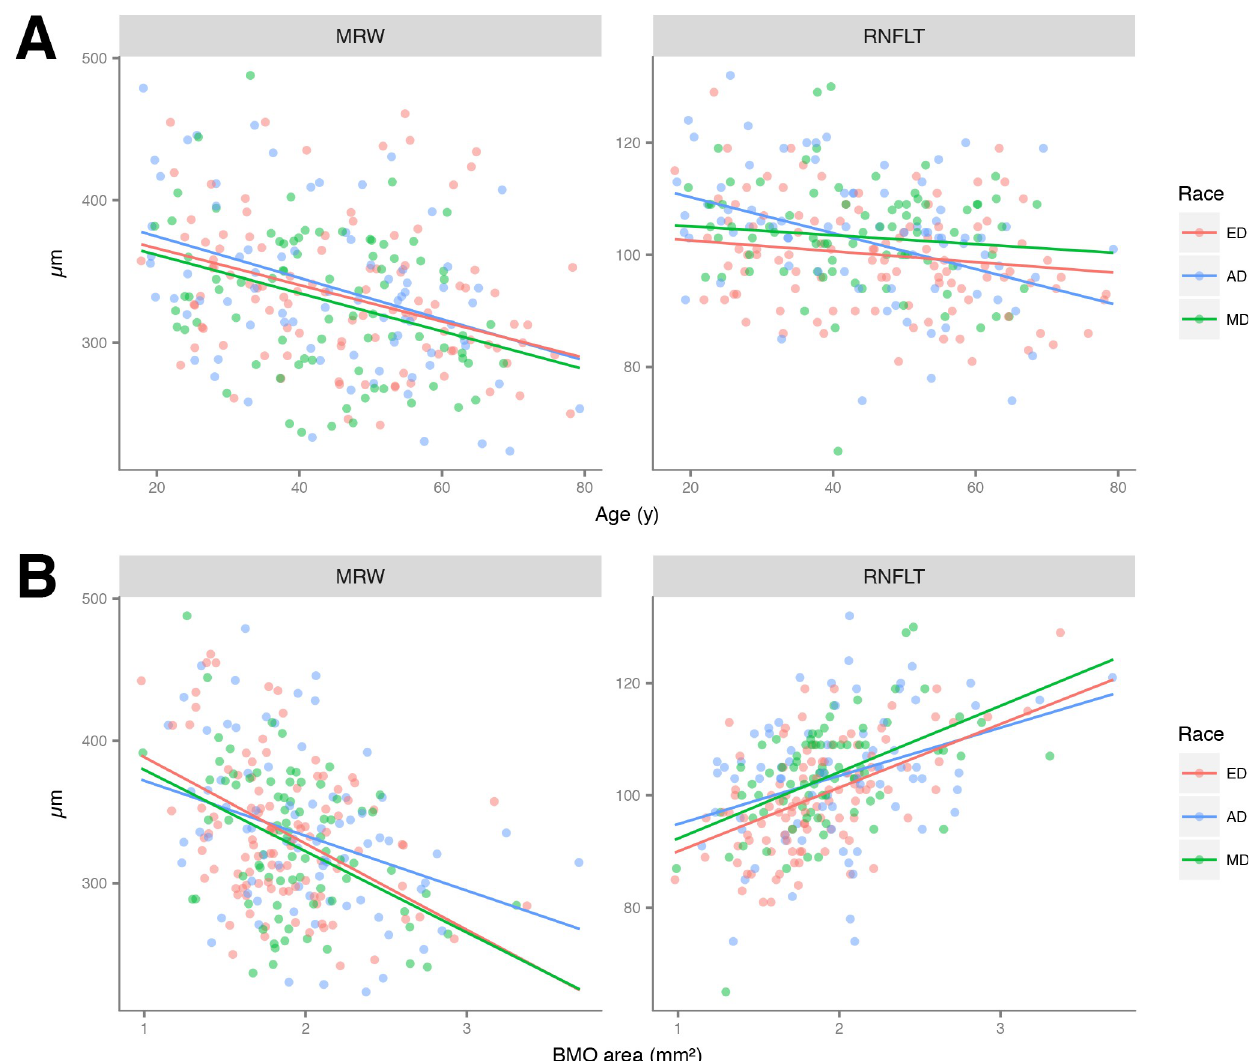
Fig 4. (A) Scatterplots showing the relationship between global minimum rim width (MRW) and age (left) and global peripapillary retinal nerve fiber layer thickness (RNFLT) and age (right), by racial group. Lines represent the coefficients of multivariable regression, adjusted for Bruch’s membrane opening area. (B) Scatterplots showing the relationship between global minimum rim width (MRW) and Bruch’s membrane opening (BMO) area (left) and global peripapillary retinal nerve fiber layer thickness (RNFLT) and BMO area (right) by racial group. Lines represent the coefficients of multivariable regression, adjusted for age. ED: European Descent; AD: African Descent; MD: Mixed